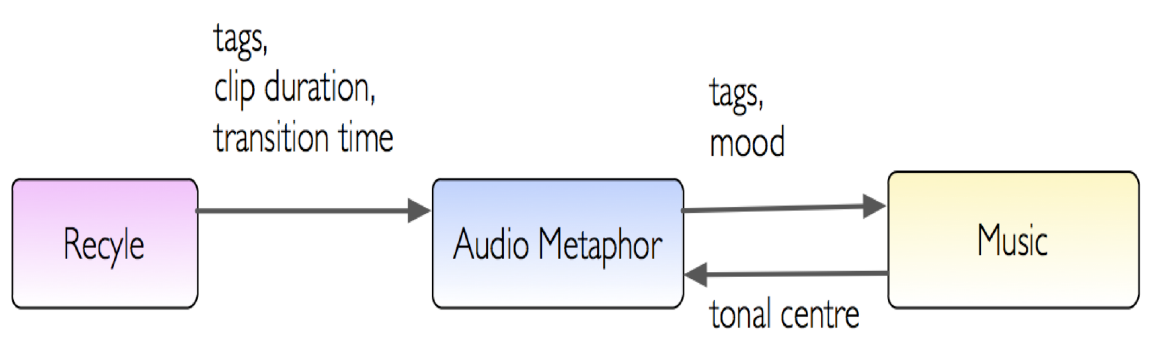
Figure 1 | MediaScape subsystem integration. Video clip metadata is communicated to Audio Metaphor for analysis and processing. Semantic tags and mood data is transferred to the music generation system. Tonal information is then sent back to Audio Metaphor to influence the ambient soundscape